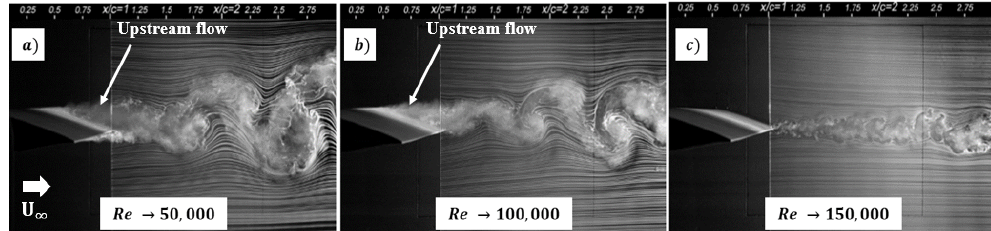
Figure 2. Vortex shedding from trailing edge of NACA 0025 airfoil at Reynolds numbers of ( a ) 50,000 ( b ) 100,000 and ( c ) 150,000.